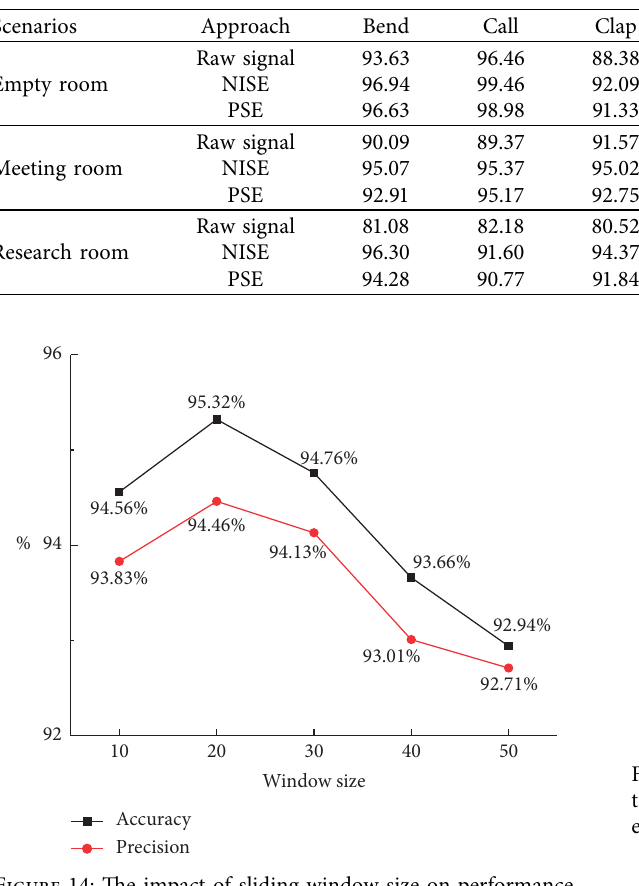
Figure 14: The impact of sliding window size on